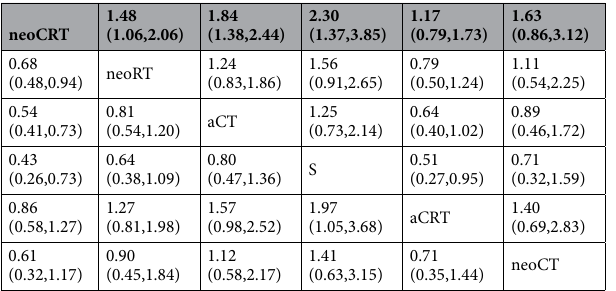
Table 1. Efficacy of all the treatments regimens in network meta-analysis (pooled HR with 95%CI).